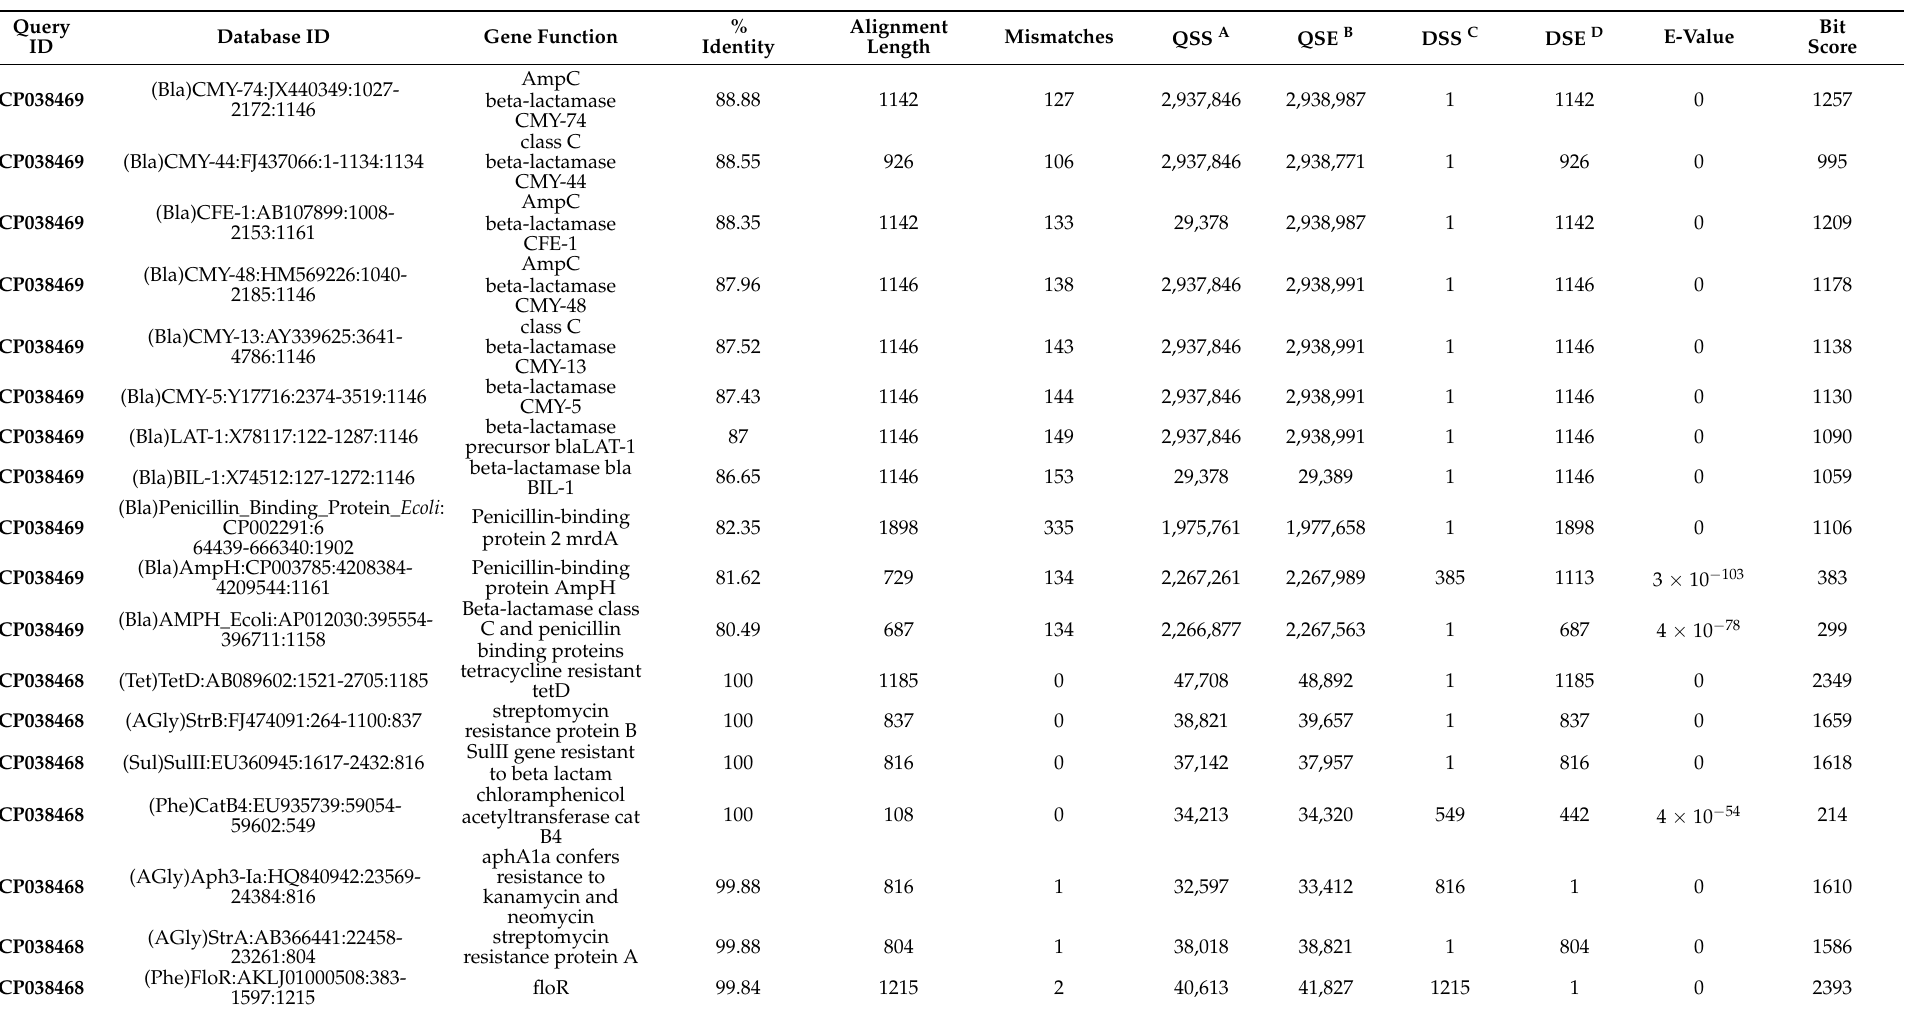
Table 2. Genes of the strain SNU WT2 related to antibiotic resistance compared with information deposited in the ARG-ANNOT database